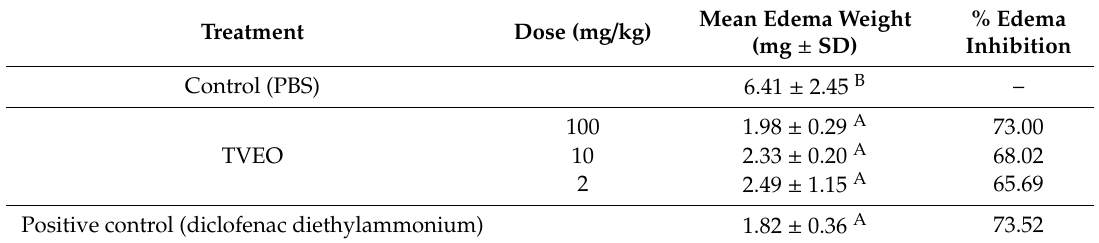
Table 6. Thyme essential oil prevents croton oil-induced ear edema in